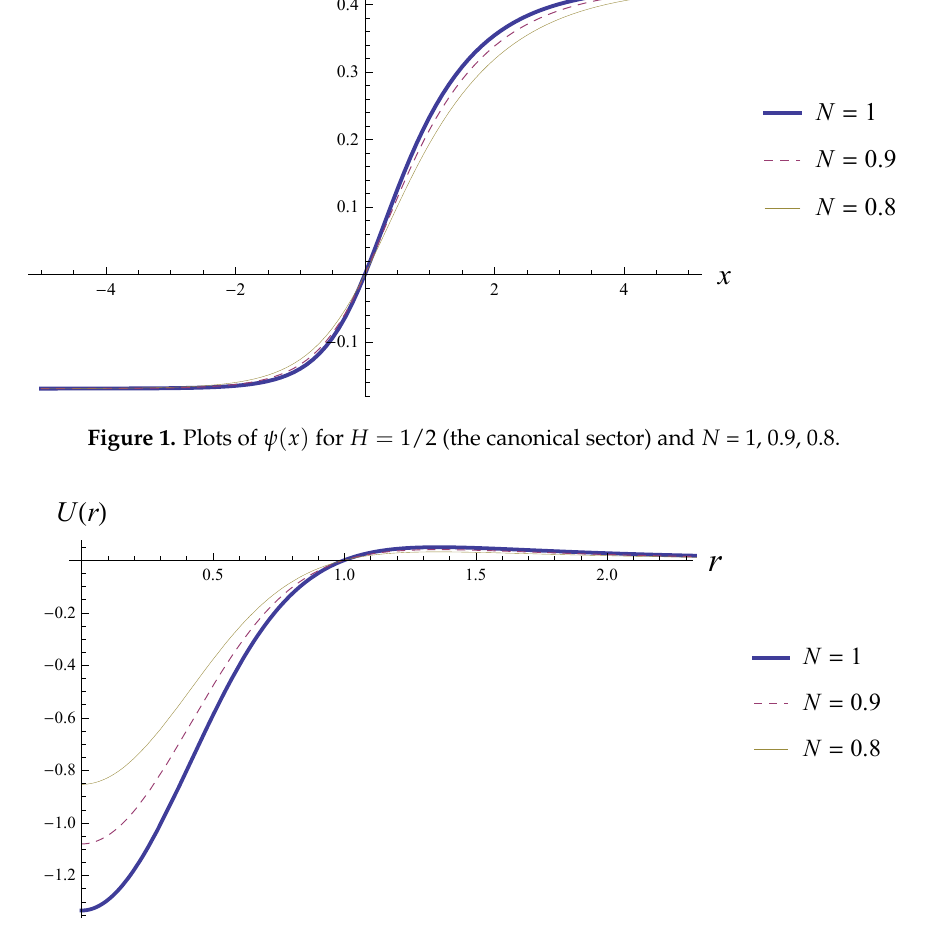
Figure 2. The potential U ( r ) in the Einstein frame for H = 1/2 and N = 1, 0.9, 0.8.